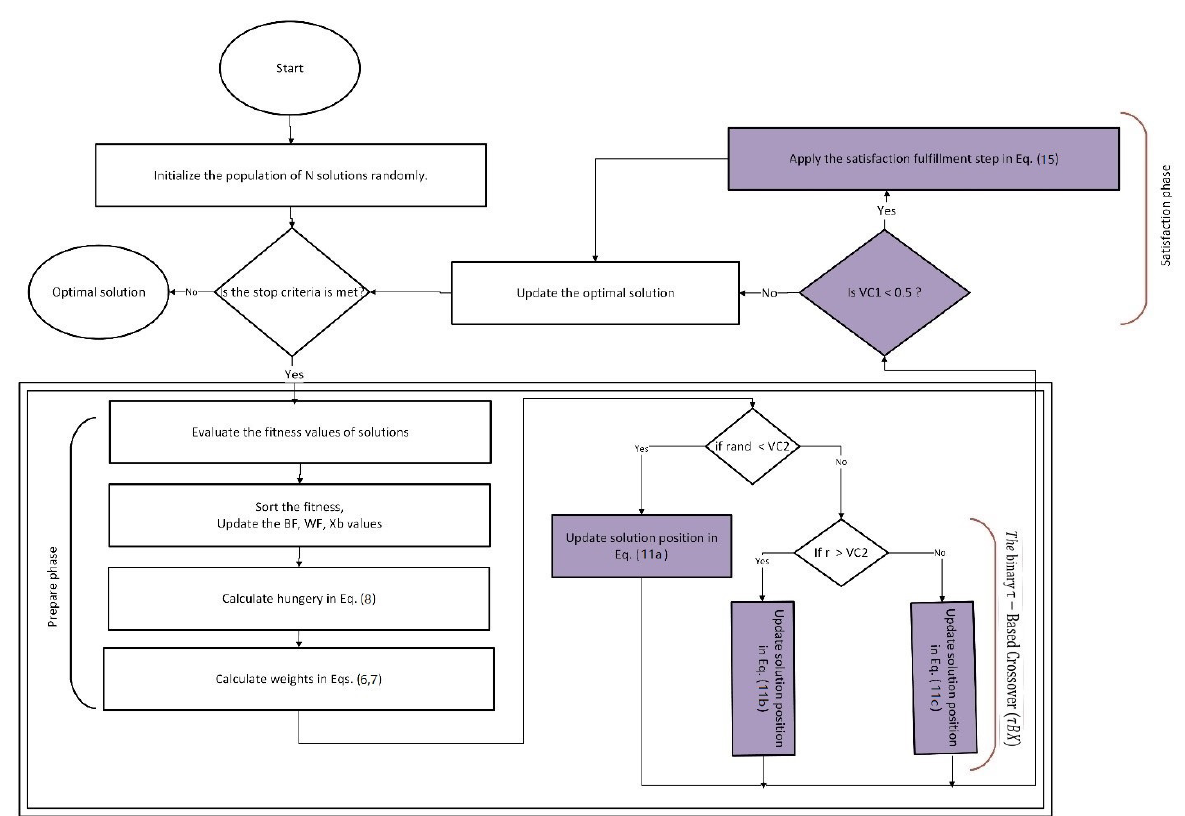
Figure 1. A flowchart illustrating the process of the proposed mHGS optimizer.